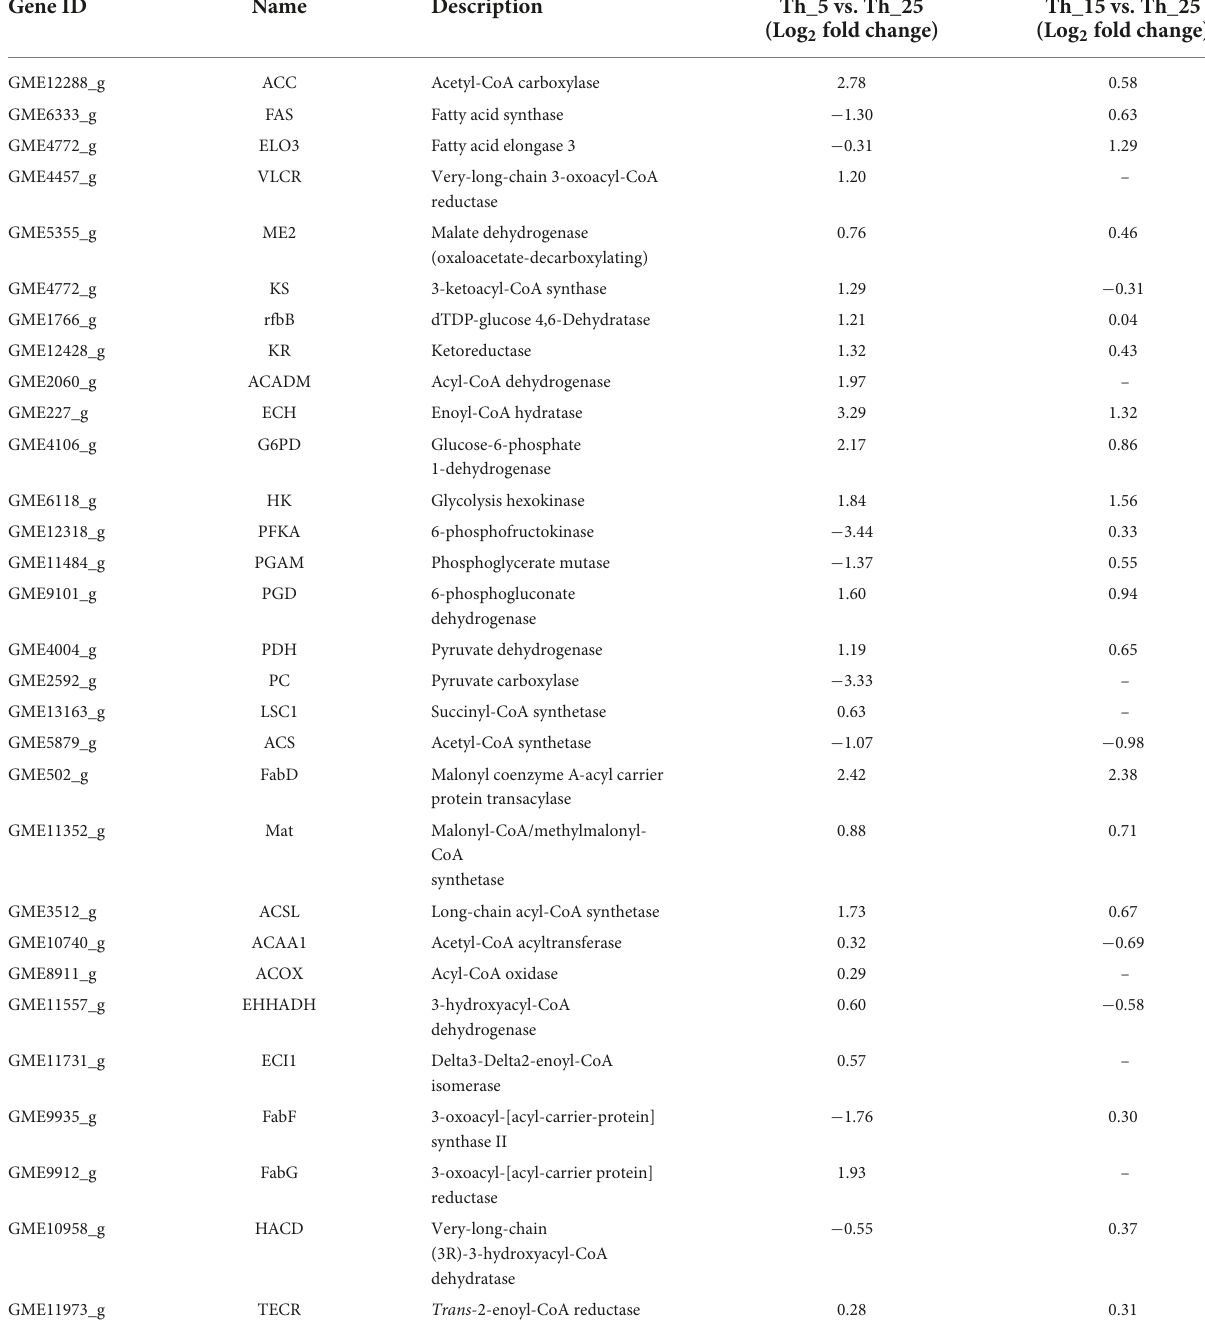
TABLE 1 Transcriptomics of the expression of genes related to fatty acids synthesis and